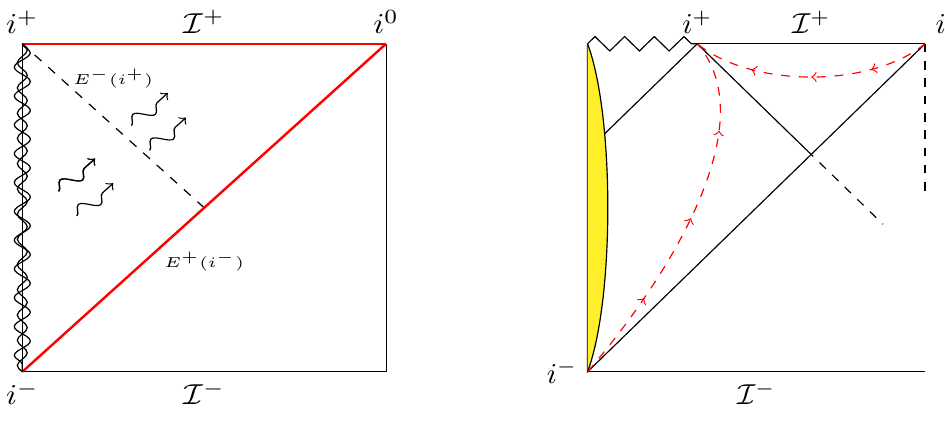
Figure 2 . Examples of NEHs in solutions with positive cosmological constant Λ . Left panel: depiction of a compact binary emitting gravitational waves. The future event horizon E + ( i − ) of i − is an NEH because there is no incoming radiation. If the emitted radiation is weak, the past horizon E − ( i + ) of i + can be regarded as a perturbed NEH. Right panel: conformal diagram depicting a spherical collapse. Shaded (yellow) region corresponds to the collapsing spherical star. The dashed (red) lines with arrows represent integral curves of the ‘static’ Killing field. Lines at 45 ◦ denote Killing horizons that are, in particular, NEHs. The inner NEH is the black hole horizon and the outer ones are cosmological